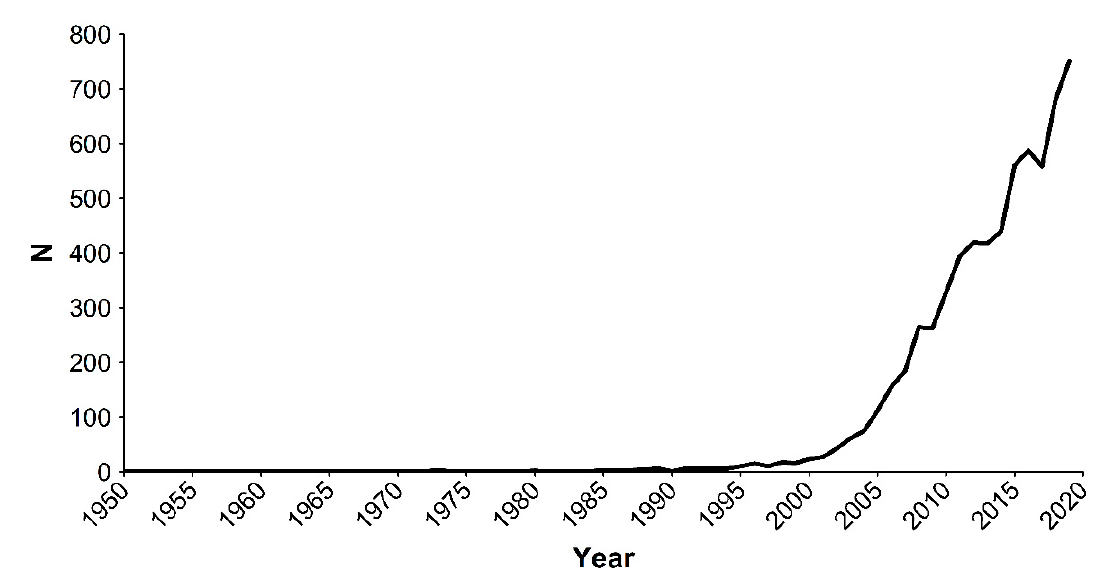
Figure 1. Temporal trend in biomimicking publications. Publications in the time interval 1950 to 2020, with n being the number of papers issued per year. One should note that data for publications of 2020 are not represented since underestimated (i.e., the search was conducted on August 2020, and not all published items for that year were included in the Scopus database).